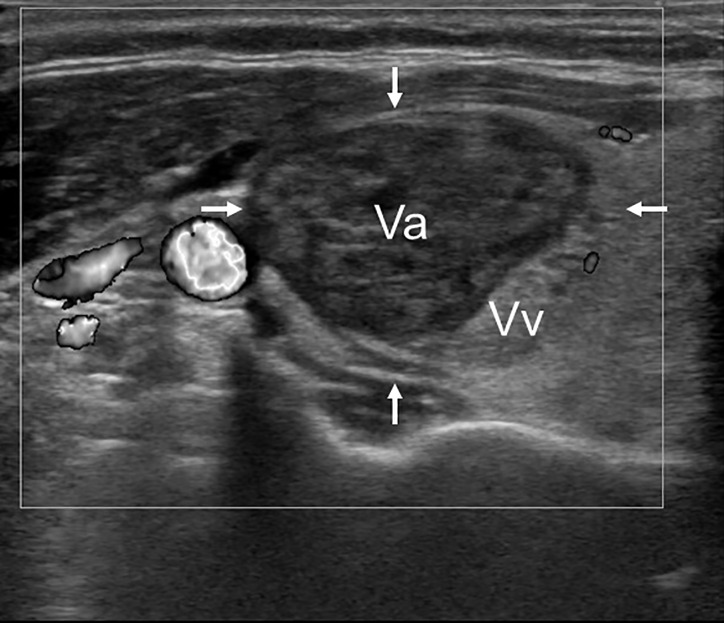
Representative B-mode US image of a thyroid nodule 1 month after RFA, showing that total volume (arrows) can be divided into an ablated volume (Va) and a vital volume (Vv). In particular, the ablated volume (which corresponds to the treated area) appears hypoechoic and avascular.